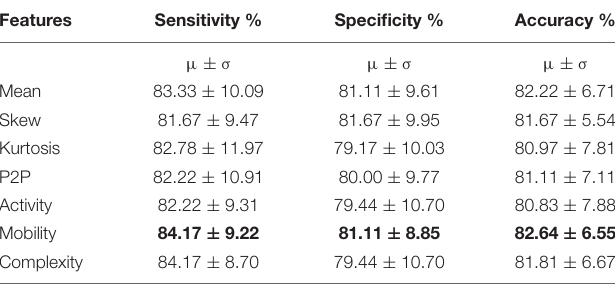
TABLE 1 | Channel classification accuracy for different network architectures. TABLE 2 | Channel classification performance parameters (with mean and variance) for active task data with individual hand-crafted time domain features using the AT-AR 3 model (training